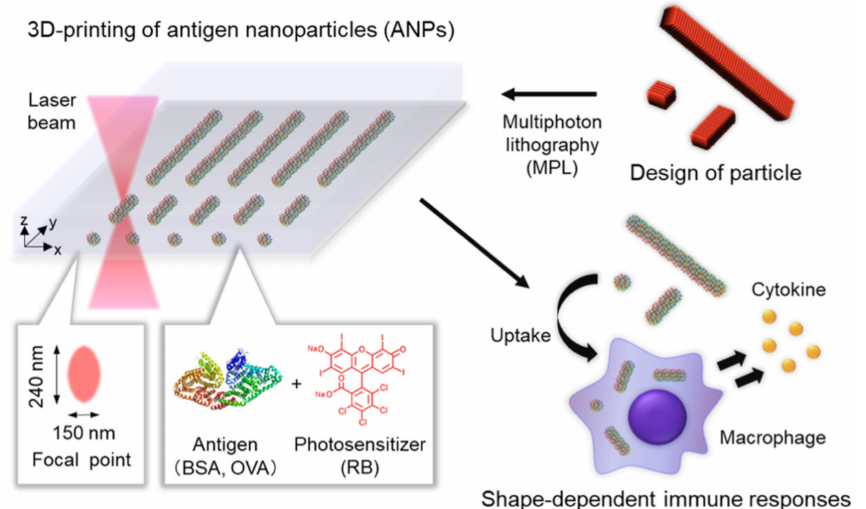
Figure 3. Graphical representation of designing ANPs using 3Dprinting where a photoresist com- posed of an antigen and a photosensitizer were used to fabricate shape-defined ANPs using mul- tiphoton lithography. The ANPs designed could be taken up by macrophage and trigger adaptive immune responses depending on particle shape. (Reproduced with permission from